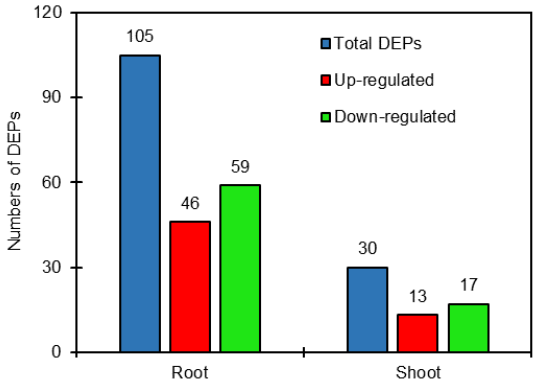
Figure 1. Number of differentially expressed proteins (DEPs) in roots and shoots of salt-treated sugar beet plants compared with untreated plants.